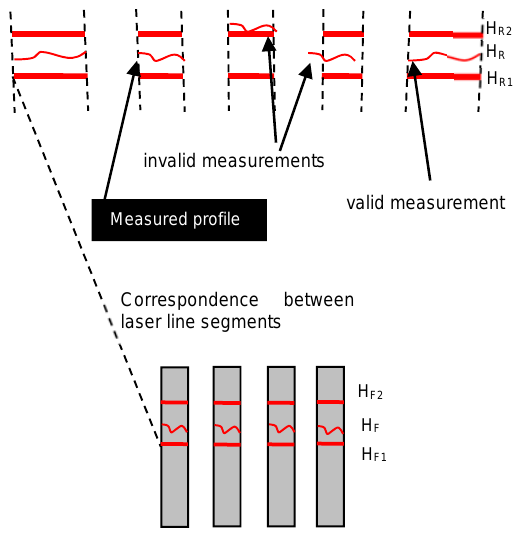
Figure 10: Validation of measurements on rear plane By defining “corridors” on the rear plane based on calibration, valid measurements (without lateral slope) can be detected (see figure 10). Obviously, a “perfect” valid measurement on a temporal horizontal will never occur. By defining suitable thresholds the problem can be solved. Another way is the interpolation of virtual measurements in the temporal domain. Each water surface patch is horizontal oriented for specific moments (assuming a random moving water surface).